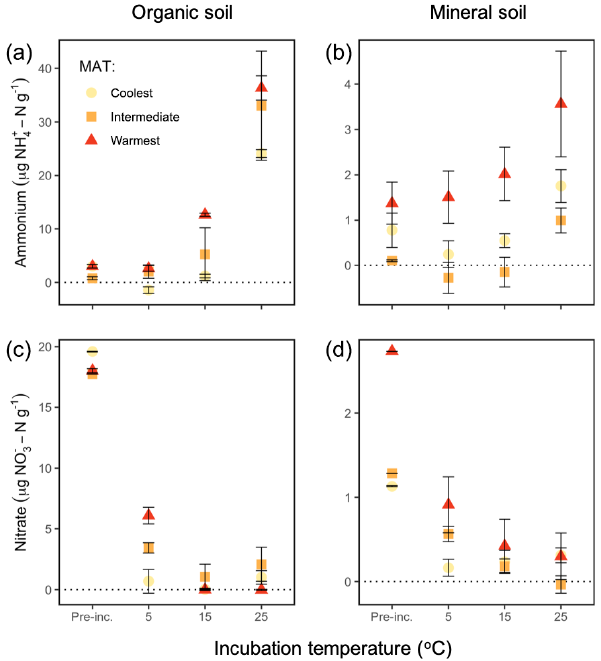
+ –N and NO − –N pools in the organic (a, c) and Figure 2. Soil NH 4 3 mineral (b, d) soil, preincubation (“Pre-inc.”) and at the end of the incubations at 5, 15, and 25 ◦ C of soils from along a boreal forest latitudinal transect. Preincubation values for nitrate are calculated as ambient concentrations including added NO − –N. Note the different 3 y axis values. “MAT” refers to the mean annual temperature. The “coolest” region is the Eagle River watershed (northern boreal), the “intermediate” region is the Salmon River watershed (mid-boreal), and the “warmest” region is the Grand Codroy watershed (southern boreal). See the text for site descriptions. Values are provided as the mean ± 1SE ( n = 3 forests per latitudinal